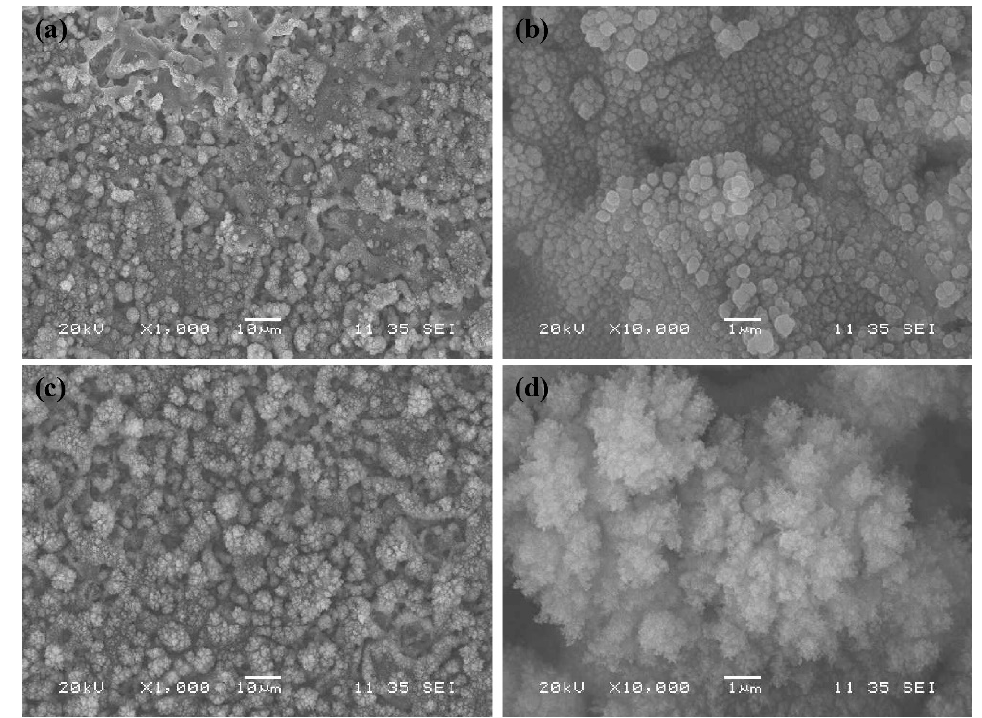
Figure 6. Surface structure of the coatings deposited without a quartz tube surrounding the jet ( a , b ) and with the quartz tube ( c , d ).